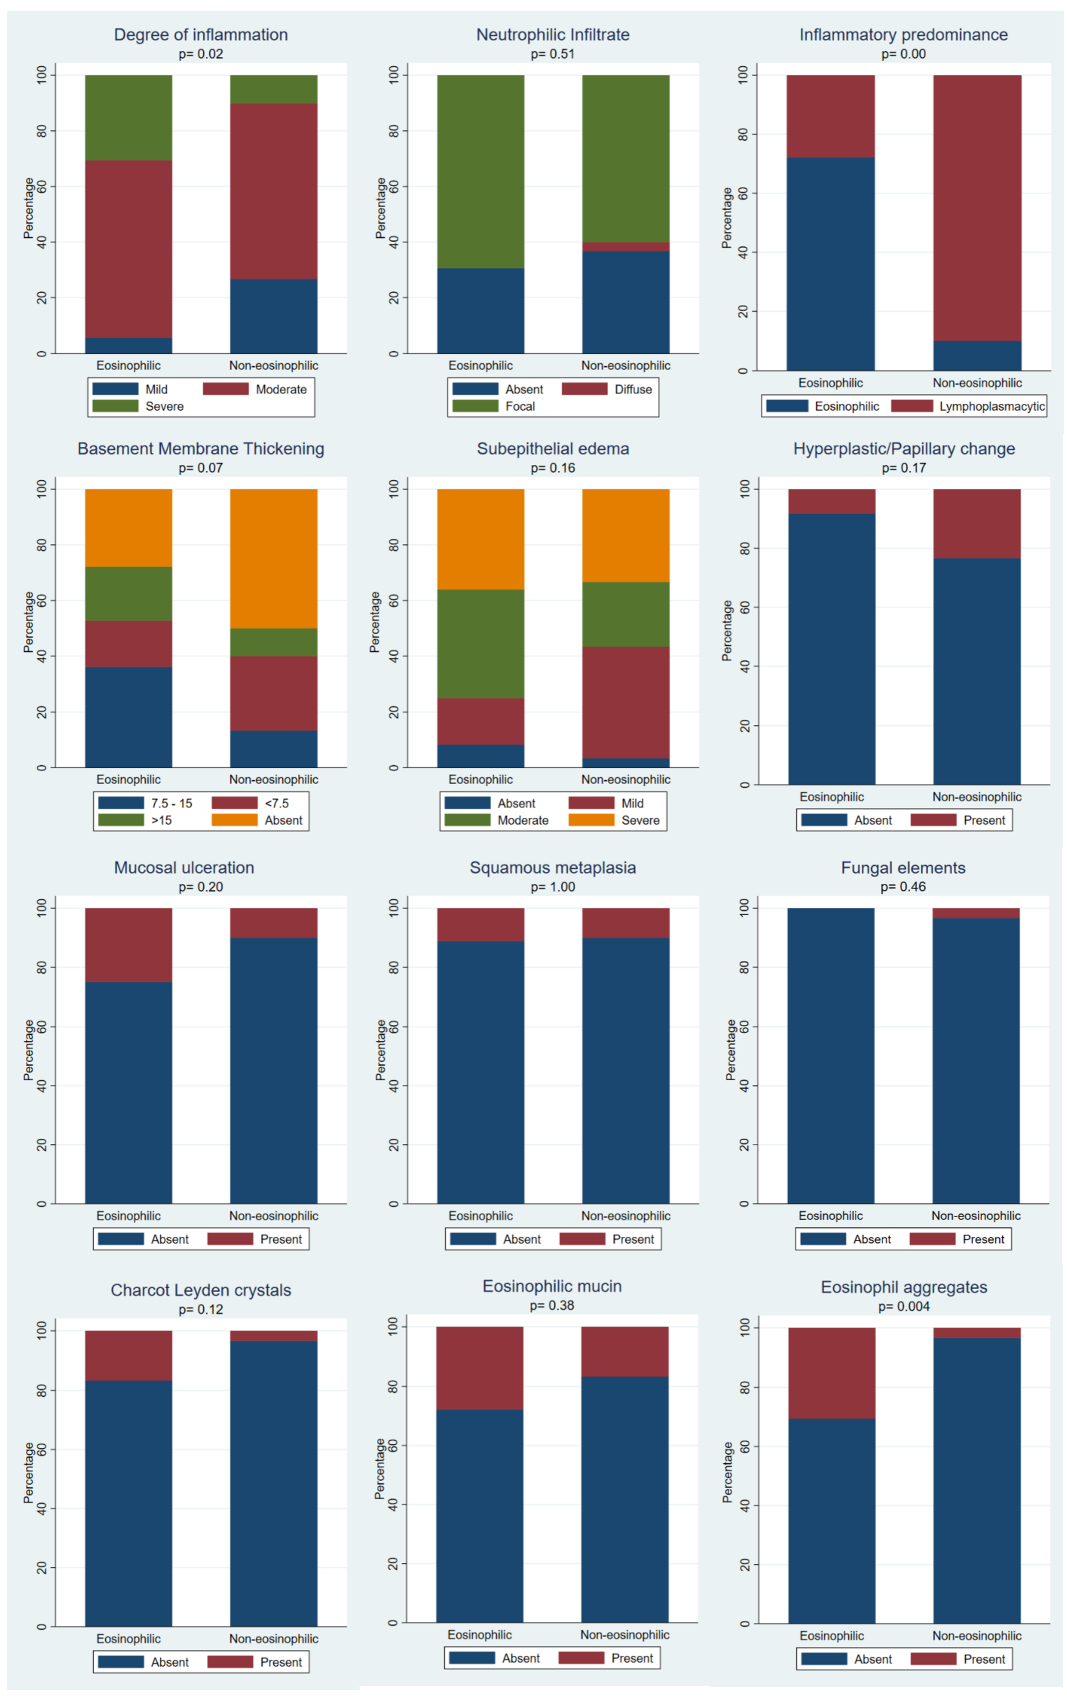
Figure 1. Comparison of histopathological characteristics between eosinophilic and non-eosinophilic